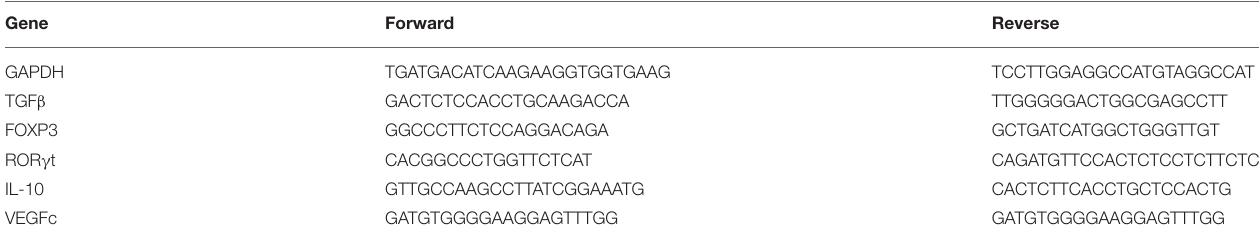
TABLE 1 | Primers used in RT-PCR assays. Gene Forward Reverse